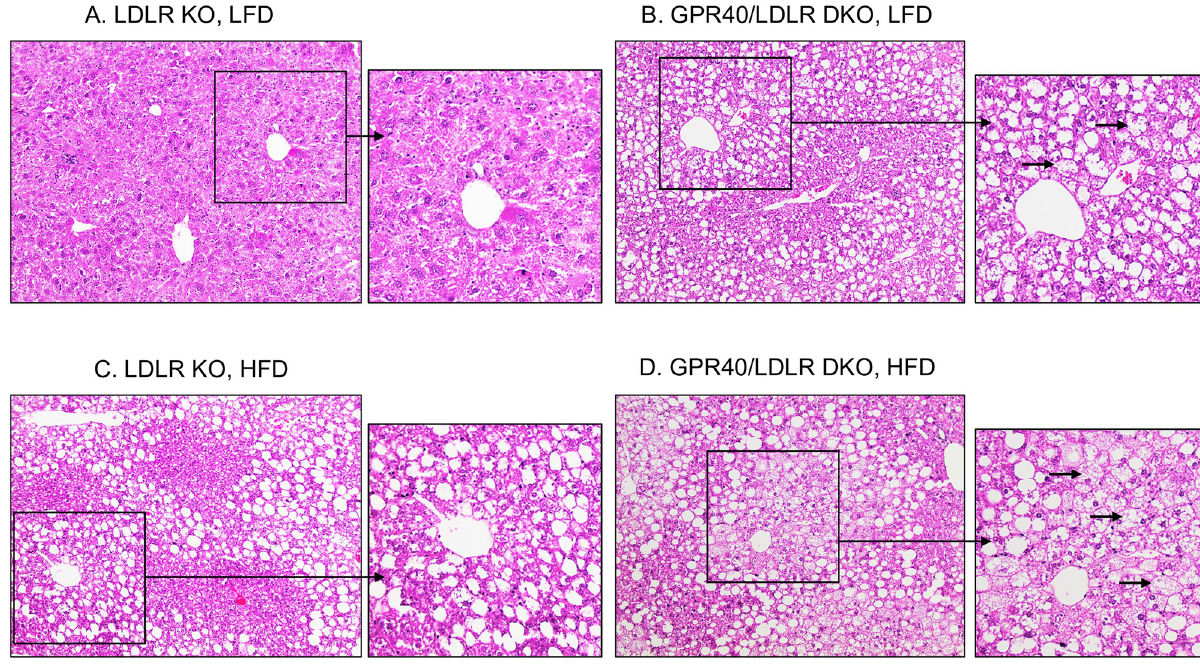
Fig 2. The effects of GPR40 KO on hepatic steatosis and hepatocellular ballooning in LFD- or HFD-fed LDLR-deficient mice. LDLR KO or GPR40/LDLR DKO mice were fed LFD or HFD for 20 wk. After the feeding, livers were dissected, and histological analysis was performed. A–D: Representative images of liver sections in four groups. The tissue sections were stained with hematoxylin and eosin and presented with low (x100) and high magnification (x400). The arrows indicate the enlarged hepatocytes with rarefied cytoplasm (hepatocellular ballooning). LFD, low-fat diet; HFD, high-fat diet; KO, knockout; DKO, double